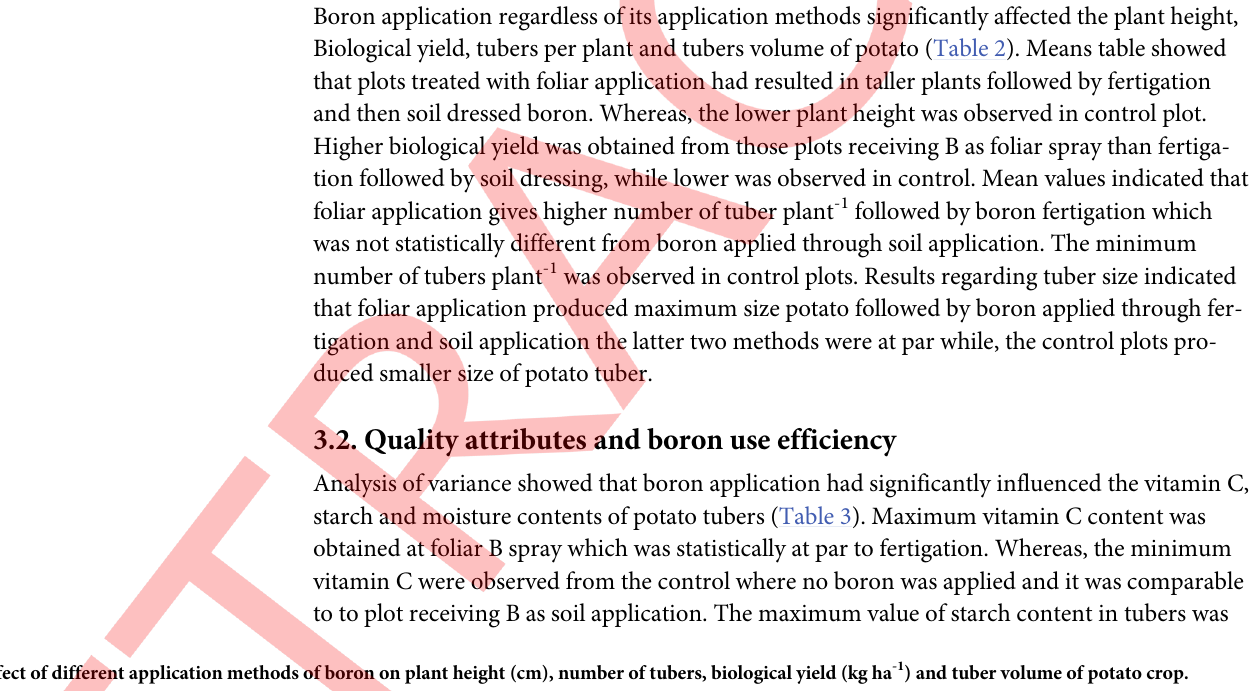
Table 2. Effect of different application methods of boron on plant height (cm), number of tubers, biological yield (kg ha -1 ) and tuber volume of potato crop. Application